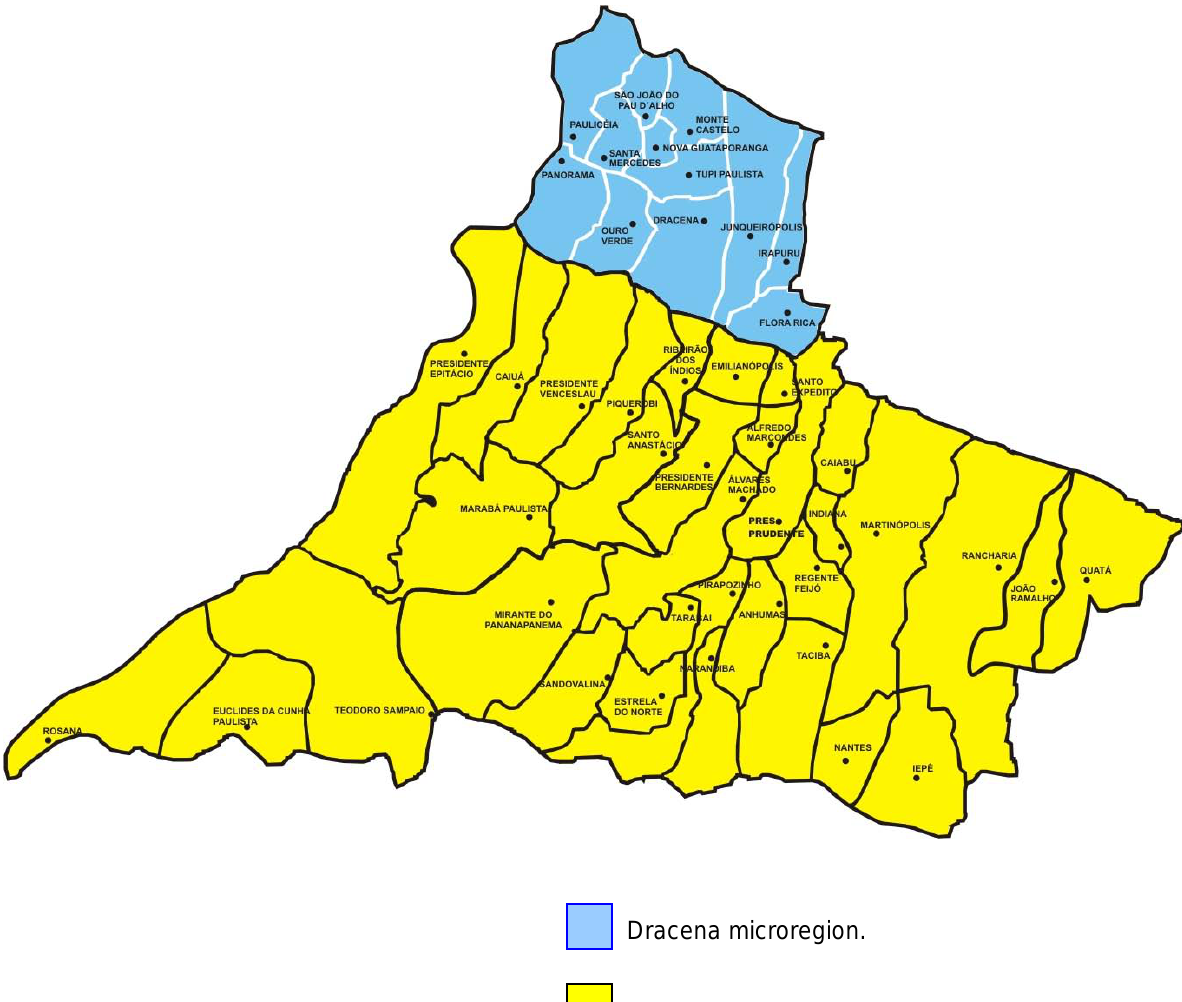
Figure 1. Cities of the 11 th Regional Division of Health – Presidente